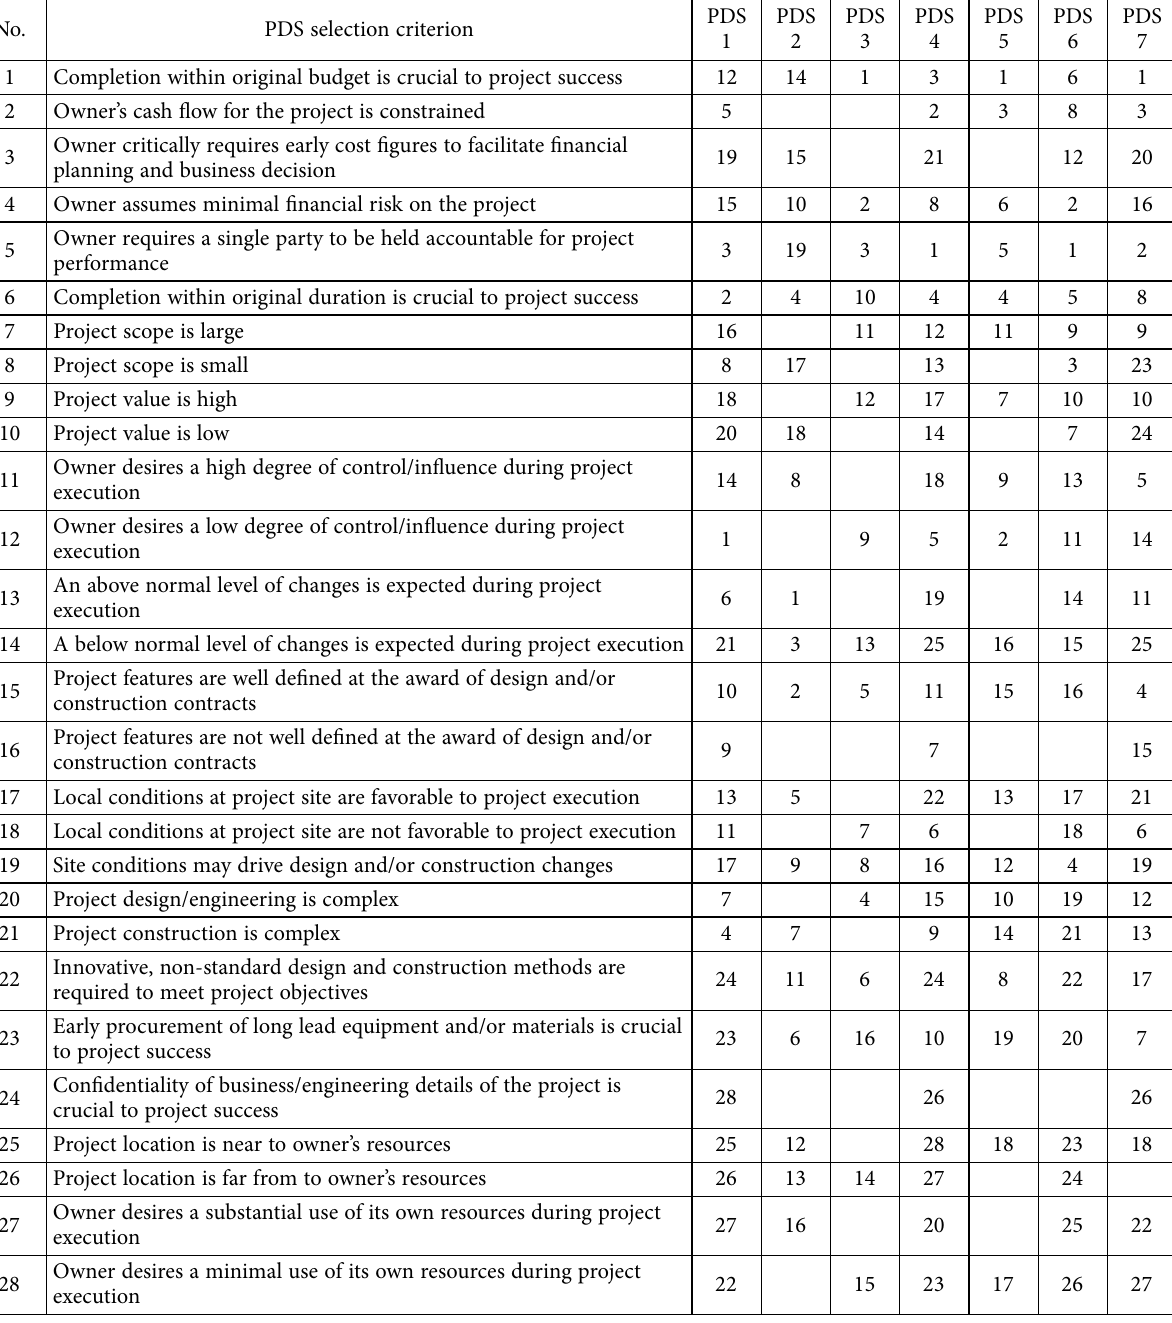
Table 4. Ranking of PDS selection